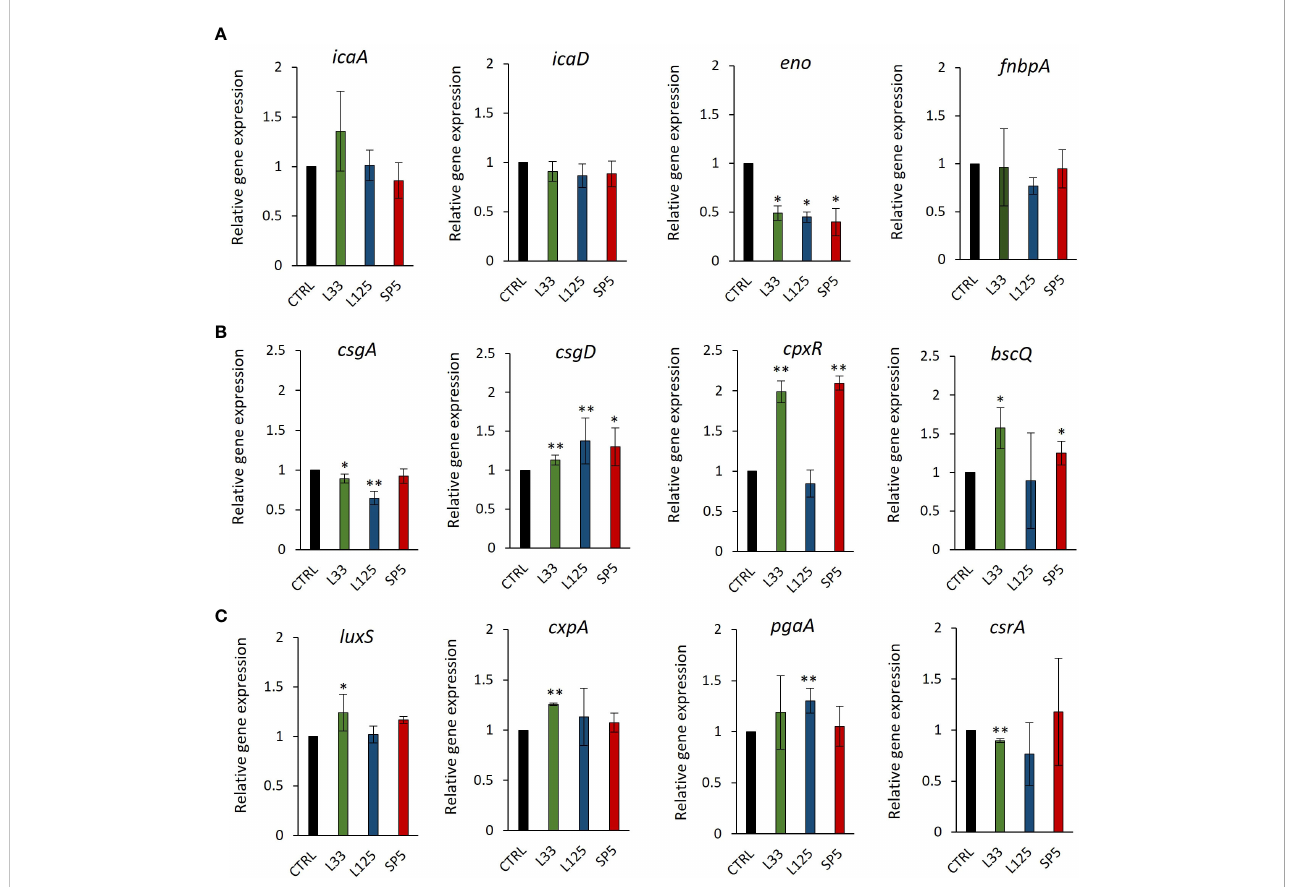
FIGURE 8 Expression levels of genes involved in bio fi lm formation after CFSE simulation for 24 hours. (A) S. aureus , (B) S. enterica and (C) E . coli , were treated with CFCS derived from Lp. plantarum L125, Lp. pentosus L33 or Lc. paracasei SP5 and TSB at a dilution ratio of 1:2 (or 50% v/v), for 24 h. The control sample was treated with uninoculated MRS medium and TSB (1:2). The data presented are the mean ± standard deviation of three independent experiments. * p < 0.05; ** p < 0.01, compared to